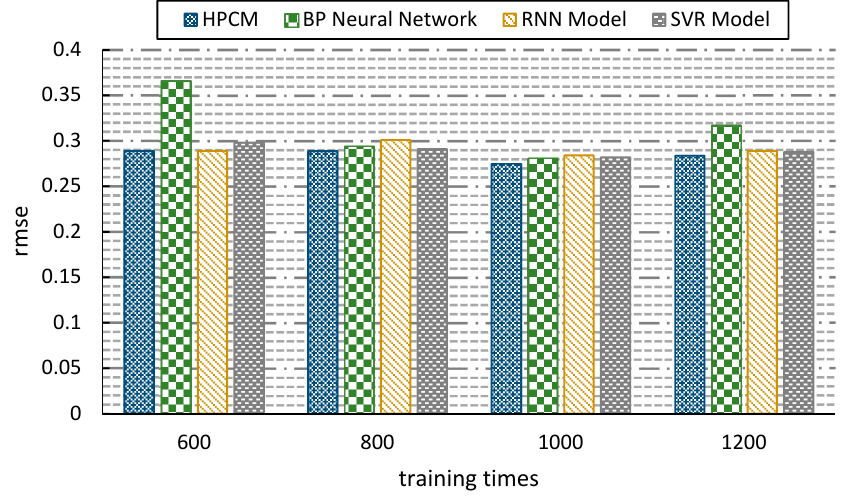
Figure 10. The root mean squared error rmse of different models under different training times.